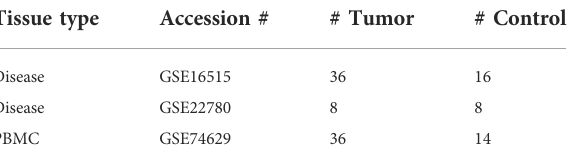
TABLE 1 Speci fi cs for the different pancreatic cancer studies used in this